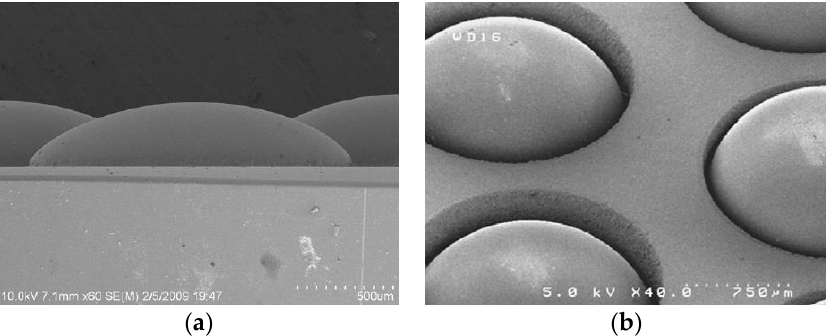
Figure 33. SEM images of ChG microlens array: ( a ) the cross-sectional image of the molded ChG microlens array and ( b ) the appearance of molded ChG microlens array [66].